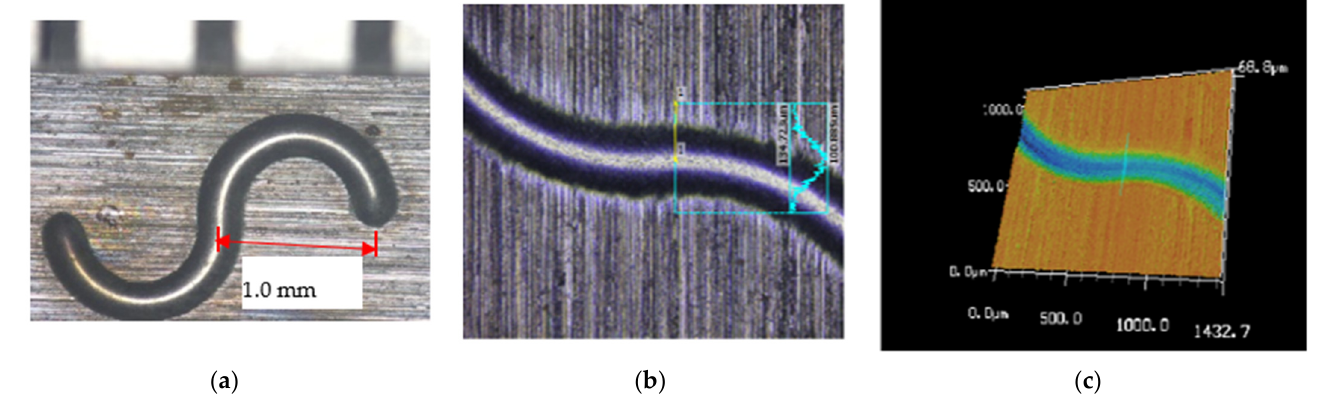
Figure 17. ( a ) The morphology of the micro S-channel with 1.0 diameter, and ( b , c ) 3D profiles of the middle section of the S-channel with 2.0 mm diameter; the scanning line reveals z-coordination from 100.3 to 134.8 μ m and the cross-section profile.